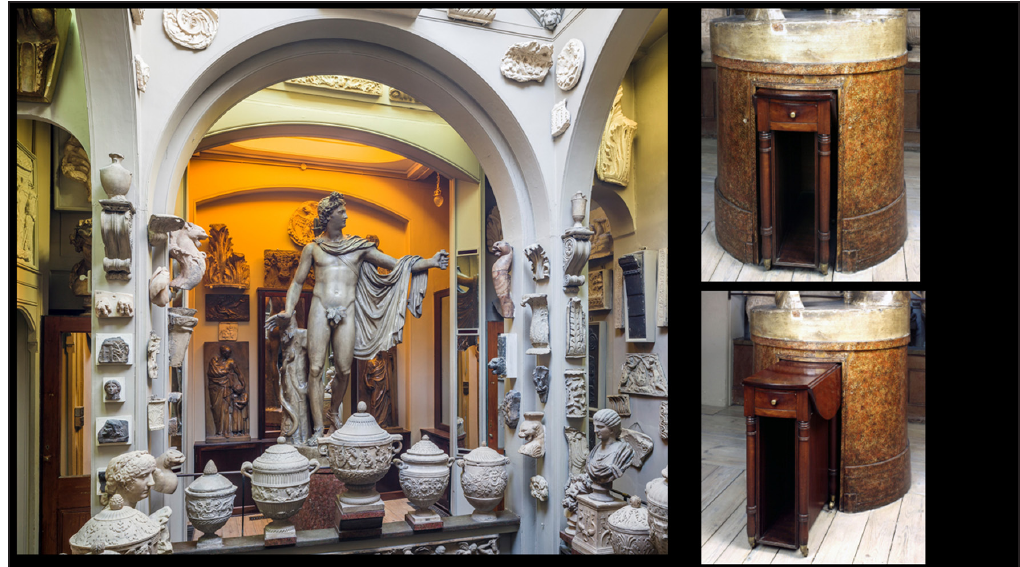
Fig. 7 : View of the Apollo recess (left). © Sir John Soane’s Museum. Photo: Gareth Gardner; and two views of the table in the Apollo pedestal (right). © Sir John Soane’s Museum. Photo: Hugh Kelly.